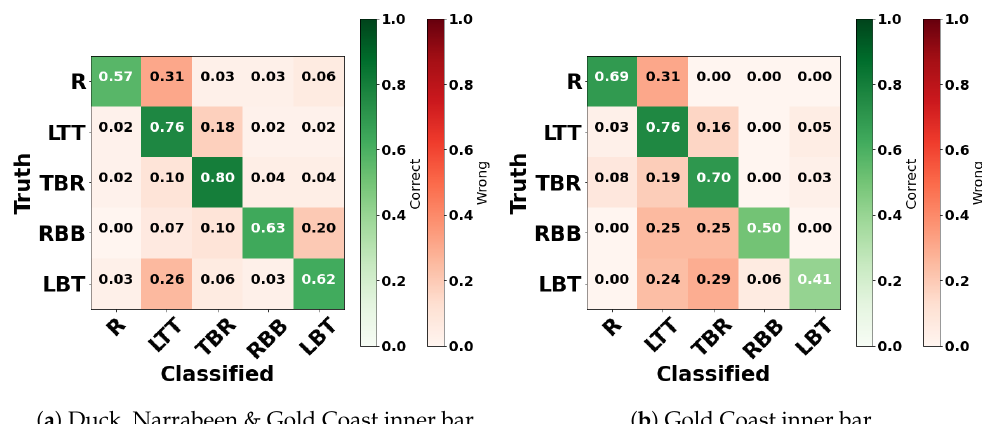
Figure 13. Normalized confusion matrices for the CombinedINNER-CNN tests: ( a ) the per-state performance of the self-test and ( b ) the per-state performance of the test at the data of the Gold Coast with the inner bar labels.